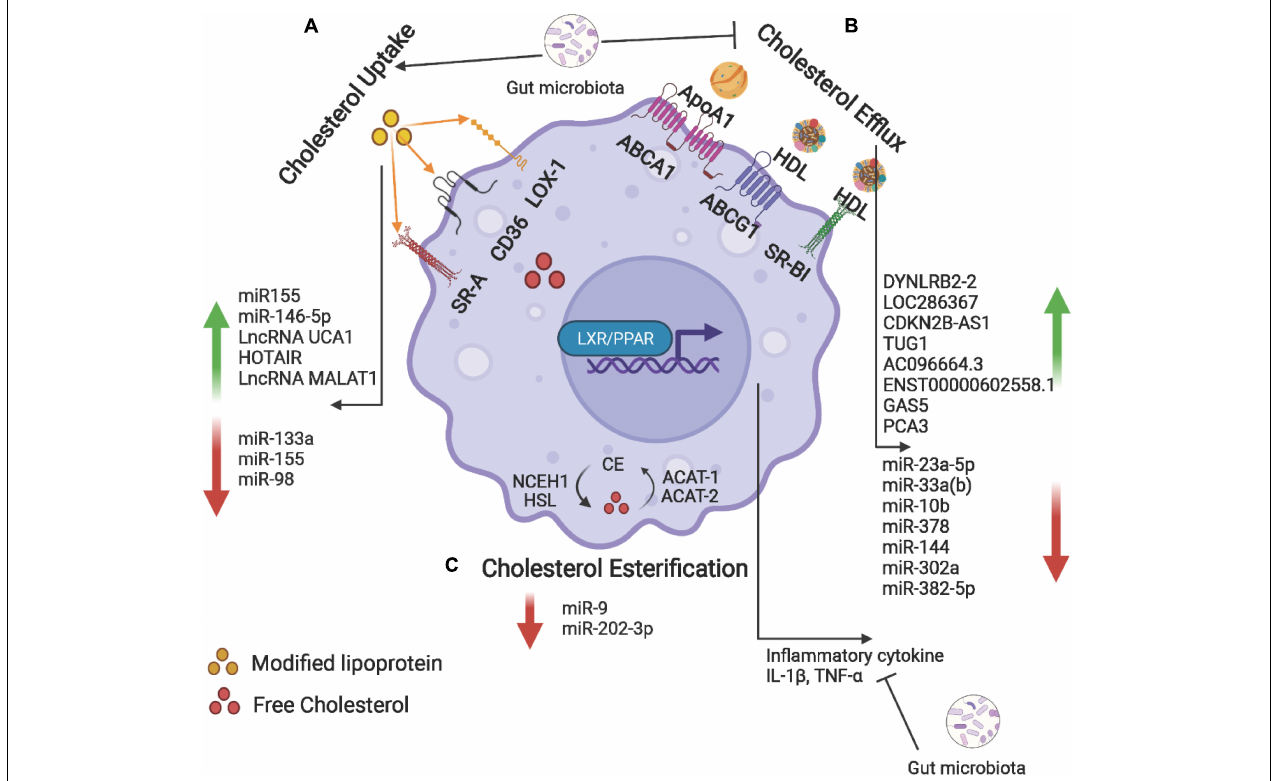
FIGURE 3 | Cholesterol uptake, efflux, and esterification in foam cells. (A) Macrophage uptake modified lipoproteins (Ox-LDL) via scavenger receptors including SR-A, CD36, and LOX-1. (B) Intracellular free cholesterol is efflux to Apo-AI and HDL via ABCA1, ABCG1, and SR-BI. (C) The internalized free cholesterol is esterified by acetyl-coenzyme A acetyltransferase (ACAT-1 and -2) and stored in lipid droplets. The ester group is removed from cholesteryl by neutral cholesteryl ester hydrolase (NCEH) to release free cholesterol. Non-coding RNAs and gut microbiota may be involved in the regulation of these processes. Created with